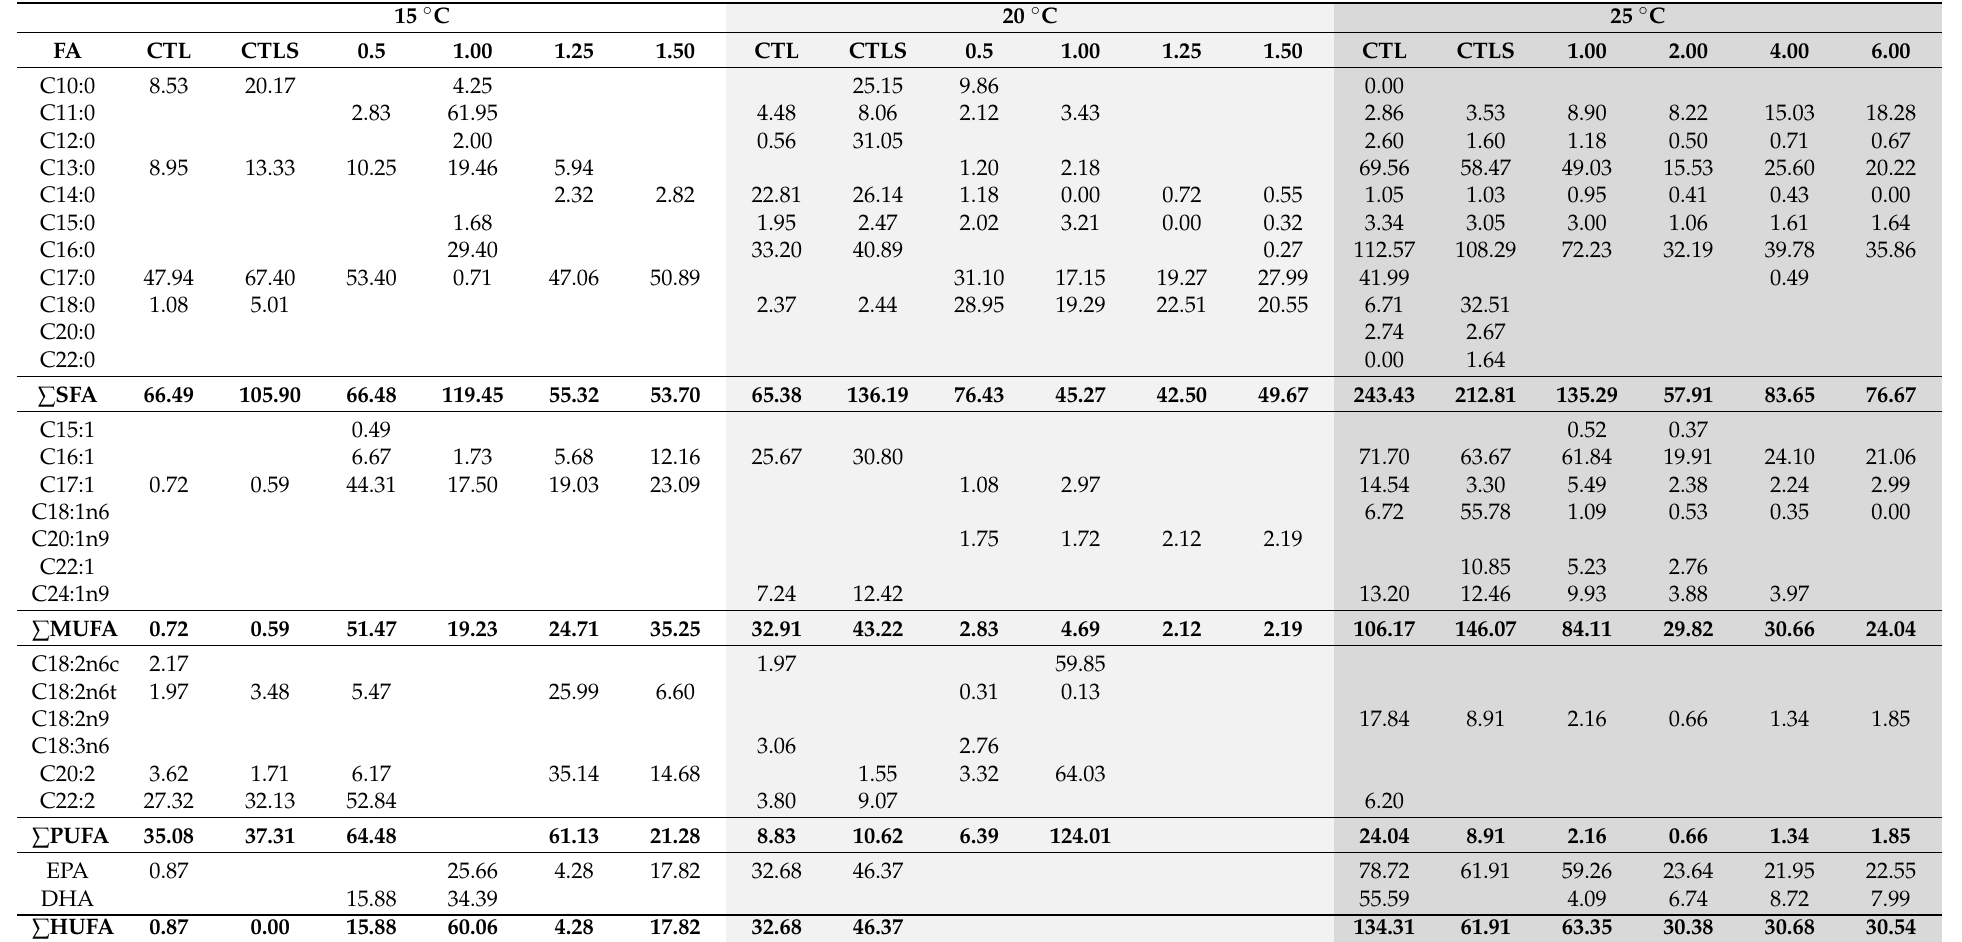
Table 2. Quantification of the fatty acid profiles (SFA, MUFA, PUFA, and HUFA at µ g/10 4 cell and expressed in %) of Thalassiosira weissflogii , determined in organisms after 7 days